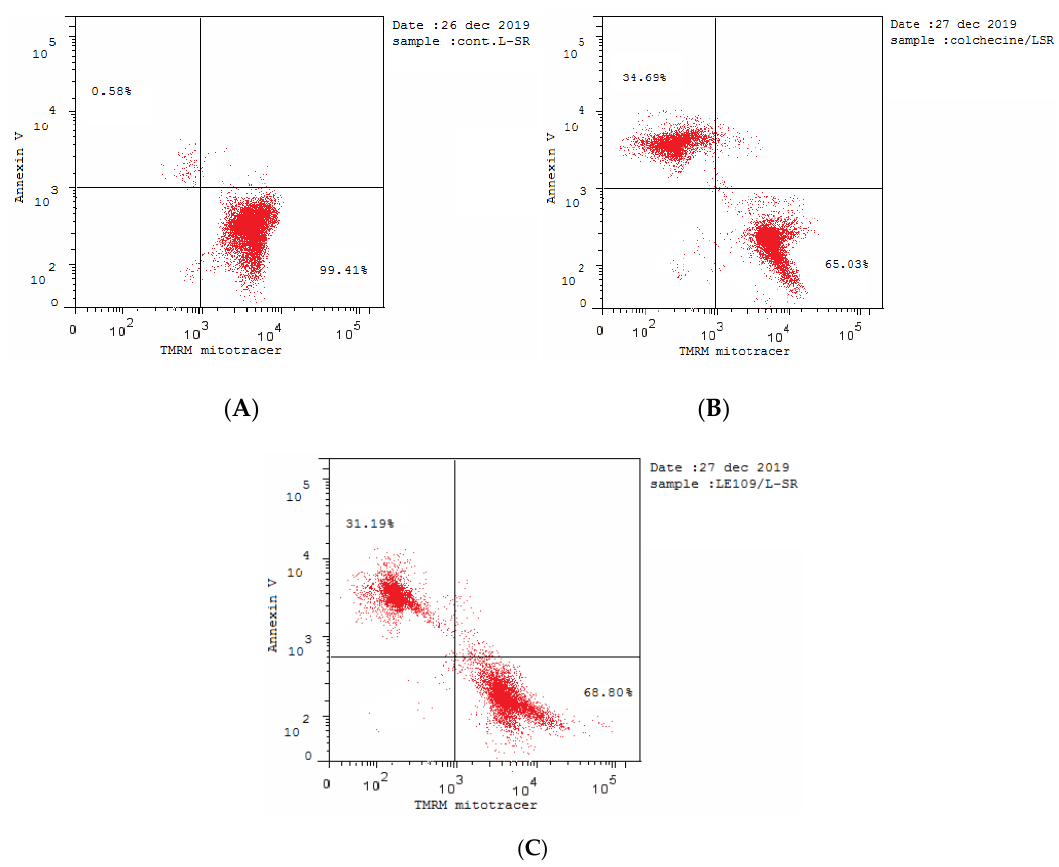
Figure 12. Contour diagram of annexin V/PI flow cytometry illustrating induction of the loss of mitochondrial membrane potential (Δψmt) against SR cancer cell line. ( A ) Untreated cells; ( B ) treated cells with colchicine; ( C ) treated cells with 3a . (B and C were performed at concentrations of 20, 10, 5, 2.5, 1.2, 0.63, and 0.31 ng/mL). The tests were repeated three times and the substrate was incubated at 37 °C in the dark for 15–30 min.